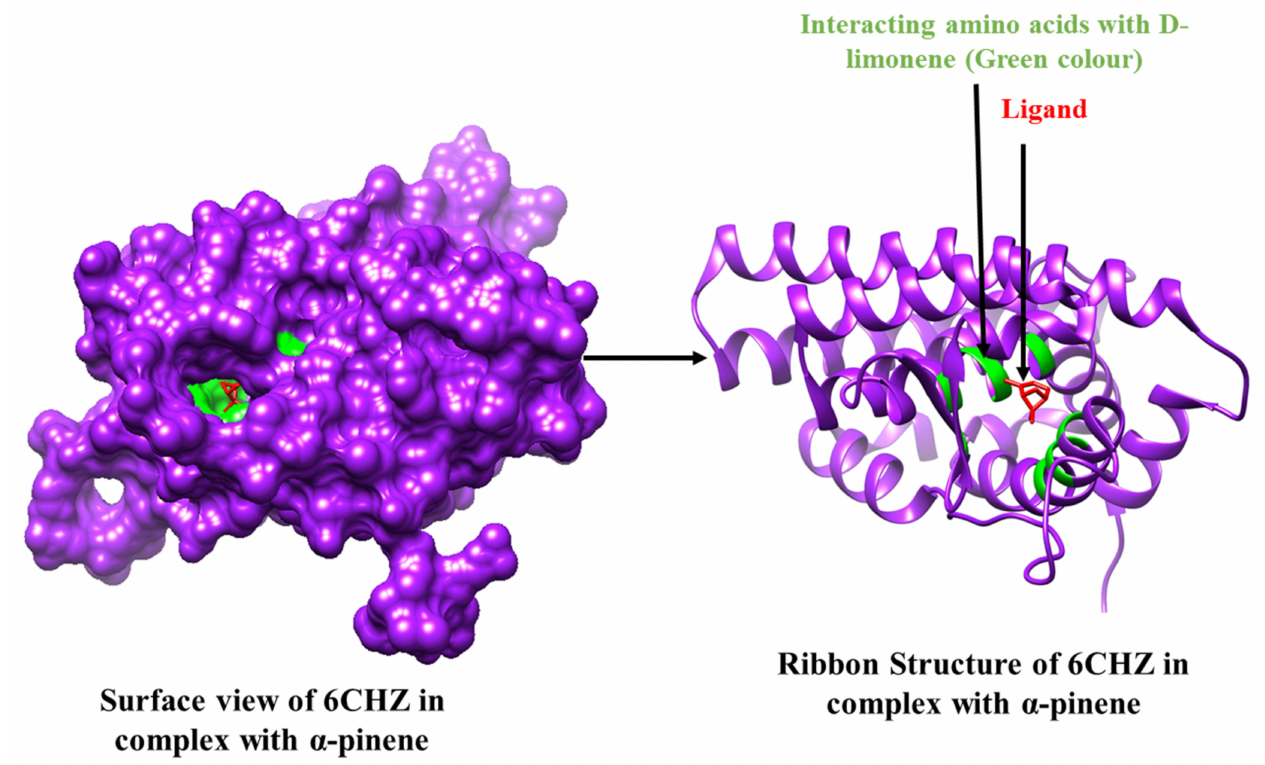
Figure 3. 3D Interaction complex of D-limonene with 6CHZ protein; purple shows the target protein, green shows the hydrophobic interactions, and red colour is shows the ligand